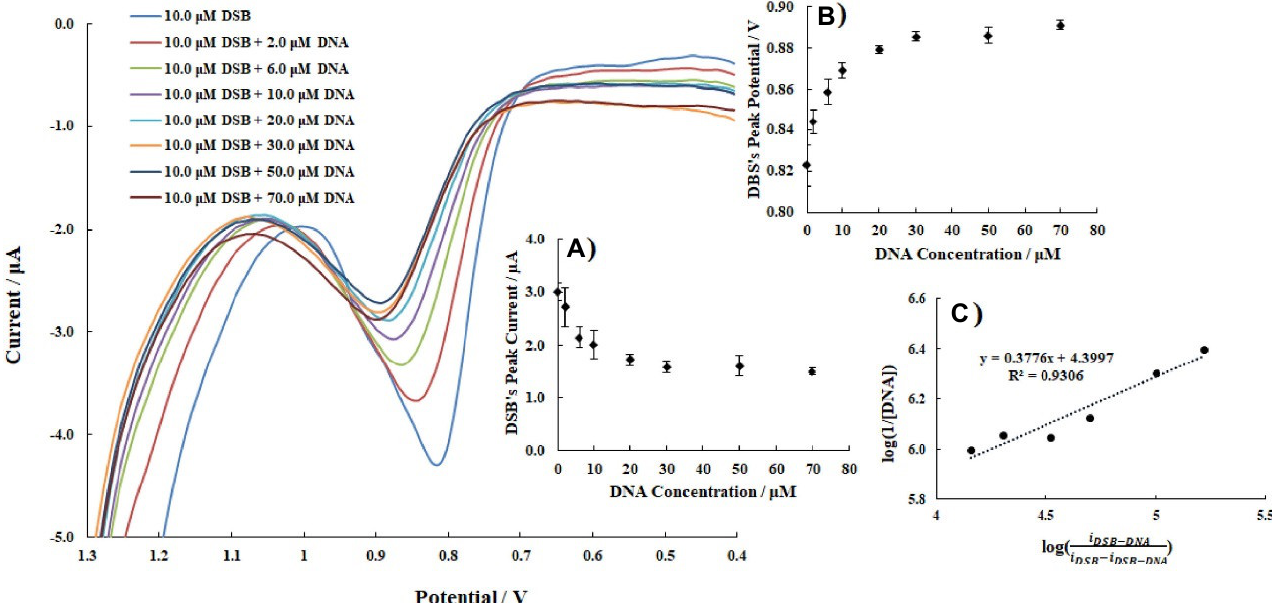
Figure 5. DPV voltammograms of 10.0 μM DSB with increasing concentrations of DNA in an acetate buffer solution with a pH of 4.8. Insets : ( a ) C DNA −i p DSB ; ( b ) C DNA −E p DSB ; ( c ) log reference [54] with permission from Elsevier.